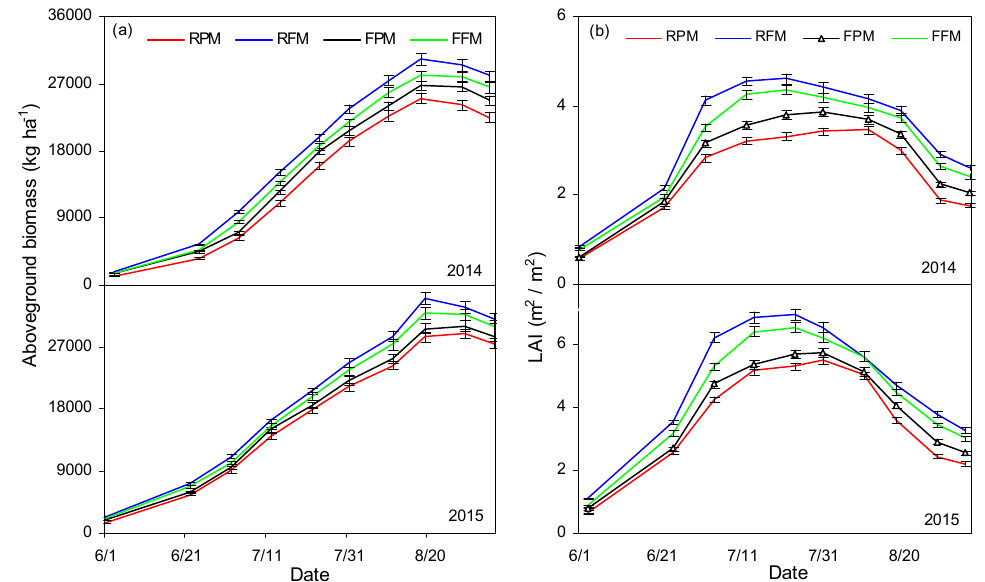
Figure 8. ( a ) Comparison of the aboveground biomass of individual maize plants in different treatments during the growth period in 2014 and 2015; ( b ) Leaf area index (LAI) of maize in different treatments during the growth period in 2014 and 2015.